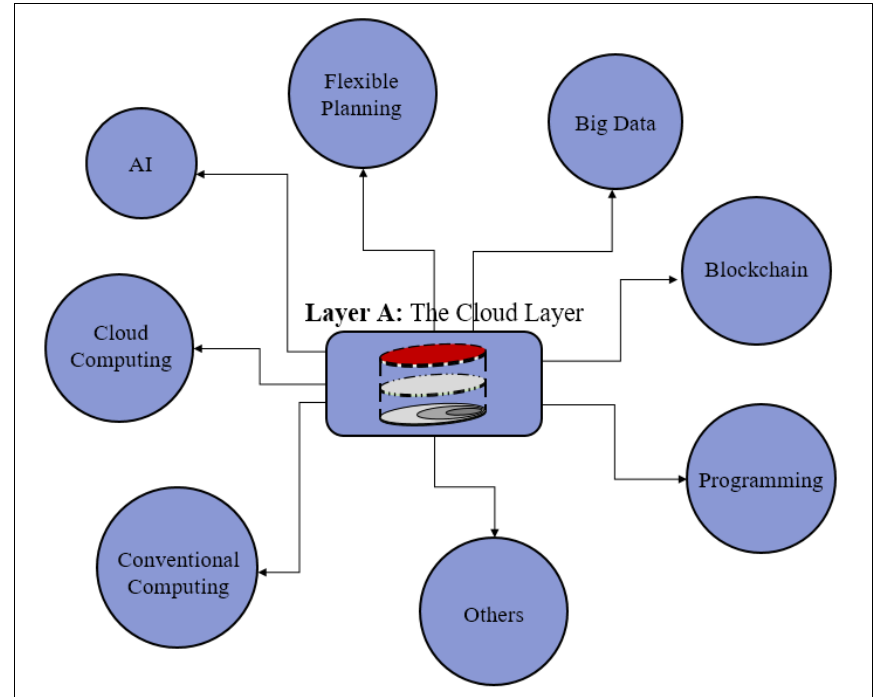
Figure 14. The main characters of Layer